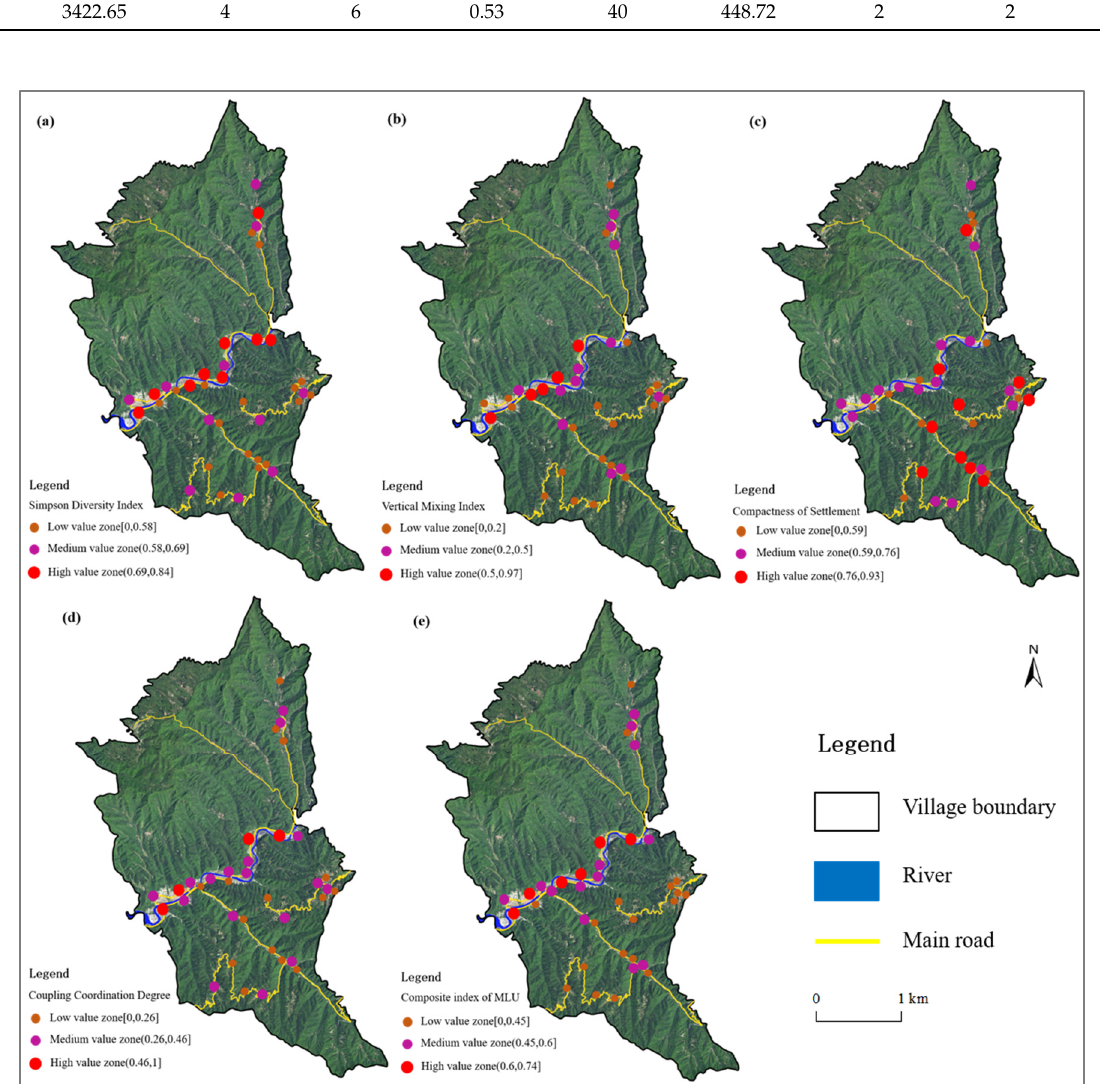
Figure 3. Spatial characteristics of the MLU of rural settlements in the study area in 2021. ( a ) the diversity index; ( b ) the vertical mixing index; ( c ) the compactness of settlement; ( d ) the coupling coordination degree; ( e ) the composite index of